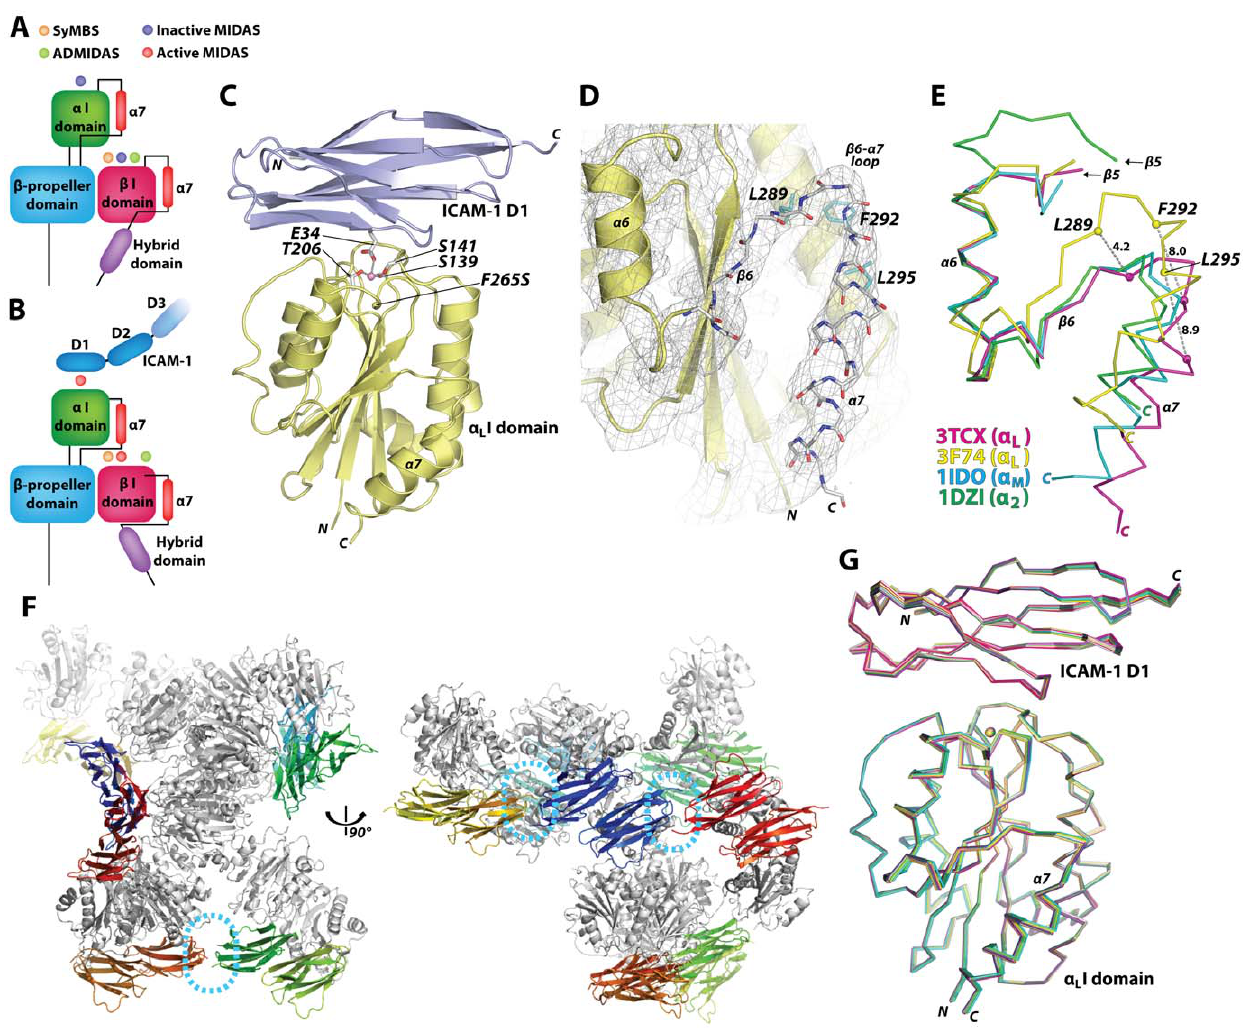
Figure 1. Complex structure of engineered a L I domain and ICAM-1 D1. (A&B) Schematic drawings of the integrin headpiece, denoting intra- and inter-domain rearrangements during the engagement of LFA-1 with ICAM-1. A structural transition from low (A) to high affinity conformation (B) involves downward displacement of the a 7-helix, shape change in metal-ion coordination sites, and swing-out movement of the hybrid domain. SyMBS=synergistic metal binding site; MIDAS=metal-ion dependent adhesion site; ADMIDAS=adjacent to MIDAS. (C) Ribbon diagram of the engineered a L I domain (pale yellow), containing a substitution of F265S, in complex with the engineered domain 1 (D1) of ICAM-1 (light purple). The residues coordinating to the metal ion in the MIDAS, Ser-139, Ser-141, and Thr-206 in I domain and Glu-34 in ICAM-1 D1 are shown in stick models. The Mg 2 + ion is shown as a pink sphere. (D) The electron density map, drawn together with cartoon or stick models, shows an open conformation of the b 6-strand and the a 7-helix. The three hydrophobic residues (Leu-289, Phe-292, and Leu-295; cyan) are shown in stick models. (E) In comparison to the previous open structures of the I domains of different a subunits, a M (1IDO; blue) [27] and a 2 (1DZI; green) [28], the a 7-helix in our structure (3TCX; magenta) shows a comparable extent of downward displacement, away from the closed structure seen in the wild-type a L I domain (3F74; yellow) [44]. (F) Ribbon diagrams of 14 complexes found in an asymmetric unit. I domains are drawn in grey, and 14 molecules of D1 are drawn in different colors for clarity. Dotted circles in cyan color indicate the interface between two C-terminal ends of D1. (G) Superimposed 14 complexes are shown as Ca-traces. doi:10.1371/journal.pone.0044124.g001 the I domain to ICAM-5 was at least 10-fold weaker than to mutant was closely superimposable (0.6 A˚ RMSD) to the I domain ICAM-1, and the I domain with two point mutations of F265S/ containing only F265S. In complexes with ICAM-1 D1D2 and F292G were necessary to form a stable complex for crystallization ICAM-3 D1, the I domains contained substitutions of two (Fig. 2A) [26]. However, the a 7-helix was found flipped upward cysteines, which were introduced to lock the a 7-helix in the pivoting on Gly-292 in the b 6- a 7 loop and the vacated space was intermediate (L161C/F299C) and the open (K287C/K294C) then occupied by the a 7-helix belonging to a neighboring I positions (Fig. 2B&C) [17,20]. Compared to these disulfide bridge domain within the crystal unit (Fig. 2A). This unnatural mutants, the b 5- a 6 loop (Gly-262 - Glu-272) of our structure was conformation of the a 7-helix would be attributed to a greater more closely superimposable to that in the high affinity mutant flexibility in dihedral angles along the peptide backbone around (RMSD = 1.8 A ˚ ) than that in the intermediate affinity mutant Gly substituted for Phe-292. However, the backbone structure (RMSD = 3.1 A ˚ ) (Figures 2B and 2C). At the same time, the b 6- a 7 excluding the a 7-helix (Asn-129 to Leu-289) of the F265S/F292G loop (Lys-276 - Val-286) of our structure was also more closely